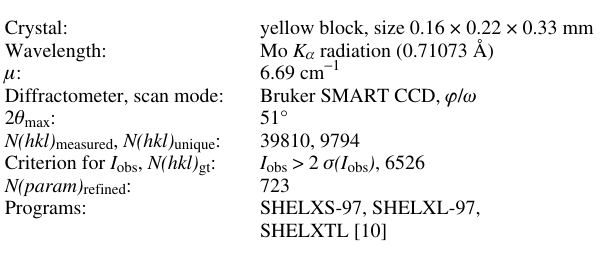
Table 1. Data collection and